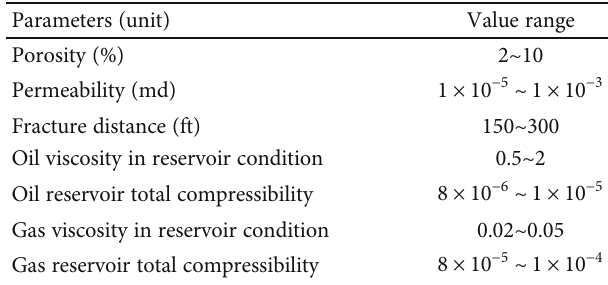
Figure 1: Schematic diagram of the compound linear fl ow model. Table 2: Parameters for calculation of Eagle